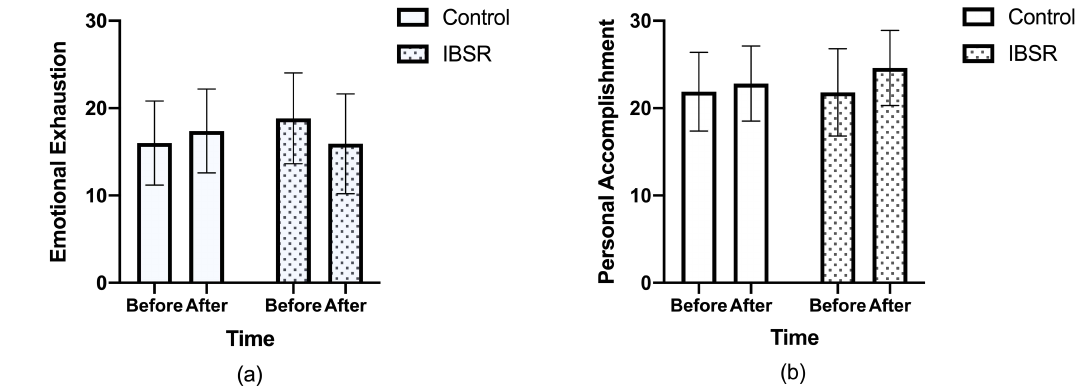
Figure 2. Change in burnout parameters. ( a ) Change in emotional exhaustion over the course of the study for the IBSR intervention group and control; ( b ) change in personal accomplishment over the course of the study for the IBSR intervention group and control. Data are displayed as means +/ − standard